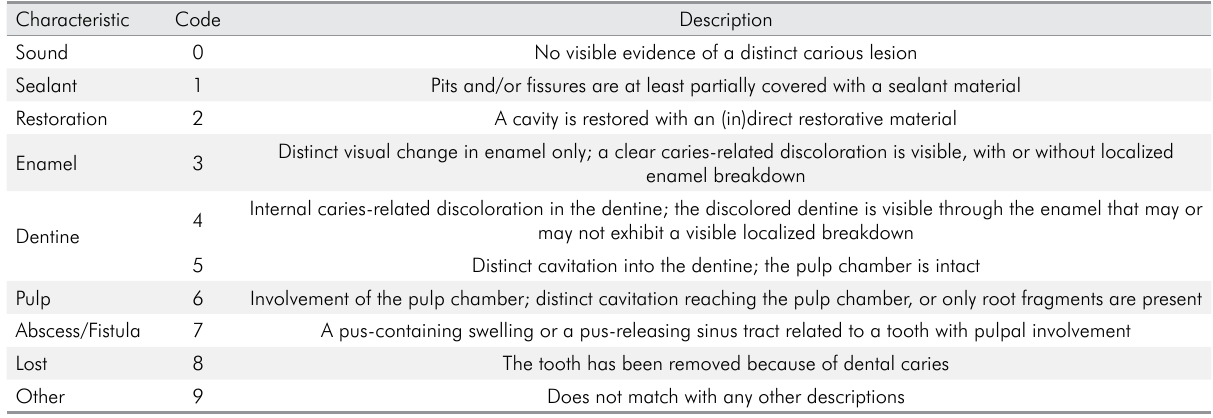
Table 1. CAST codes and